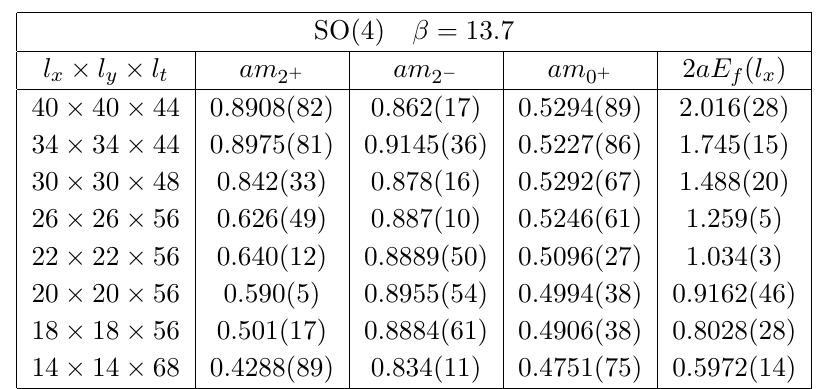
Figure 6 . Lightest scalar ( (cid:15) ) and tensor ( (cid:4) ) glueballs in SO(4) on various spatial volumes, l 2 , all in units of the in(cid:12)nite volume mass gap M g . And the same for SU(2) ( (cid:14) ; (cid:3) respectively). Also shown is twice the fundamental (cid:13)ux loop mass in SU(2) ( 4 ) and SO(4) ( N ).